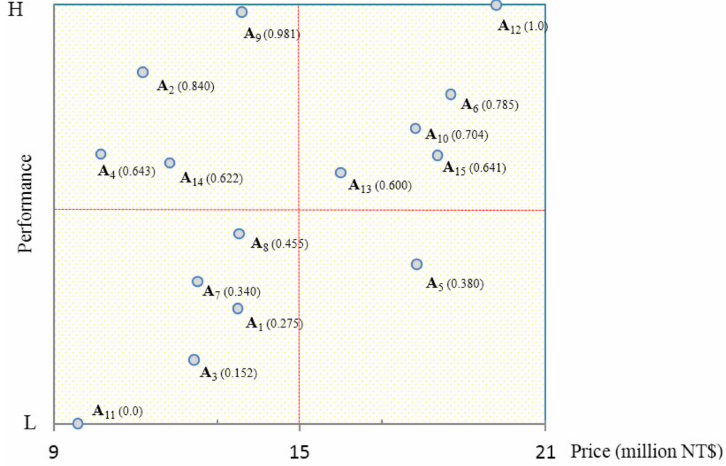
Figure 3. Price-Score (real estate performance) evaluation